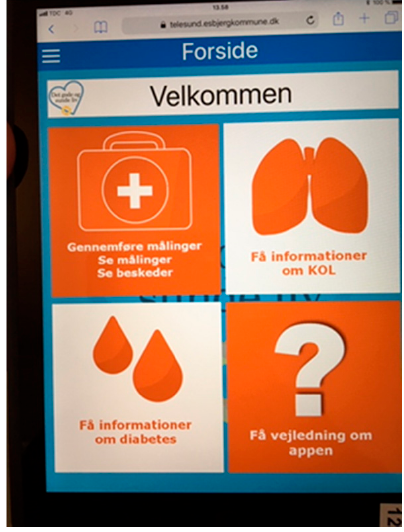
Figure 1. Appliance for measuring oxygen saturation at home.